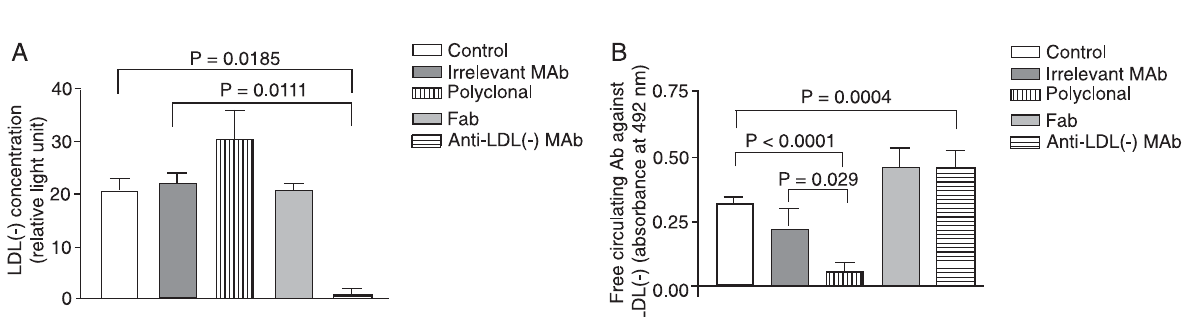
Figure 4. Determination of electronegative low-density lipoprotein [LDL(-)] and its autoantibodies in blood plasma of low-density lipoprotein receptor-deficient (LDLr-/-) mice not treated or treated with irrelevant monoclonal antibody (MAb, 100 µg), anti-LDL(-) MAb (100 µg), rabbit anti-LDL(-) polyclonal antibody (100 µg) or Fab fragments from rabbit anti-LDL(-) polyclonal antibody (100 µg). A, Concentration of LDL(-). B, Levels of free circulating antibodies (Ab) reactive to LDL(-). P < 0.05, ANOVA followed by the Tukey-Kramer